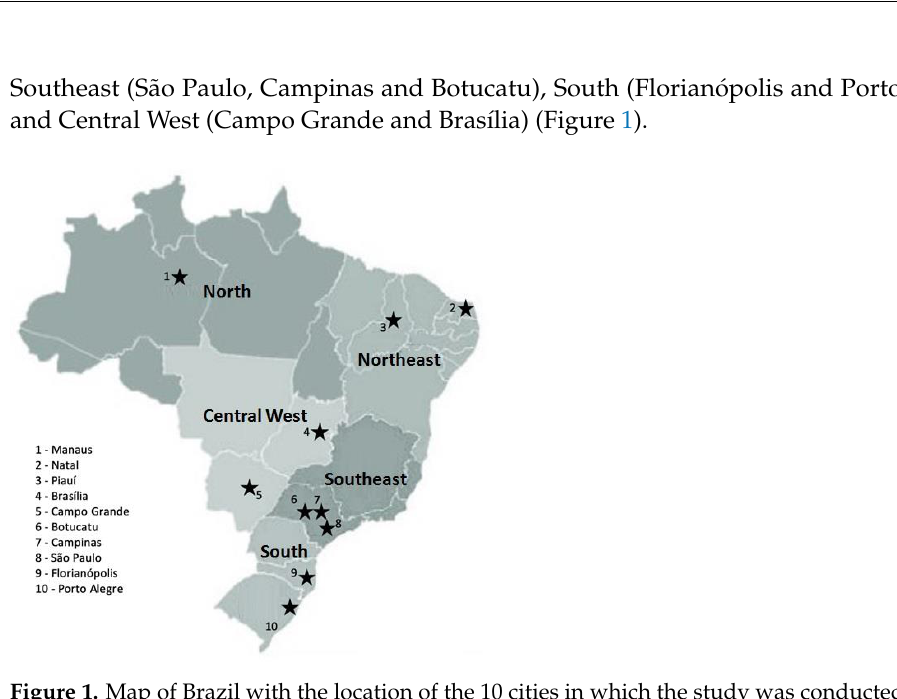
Figure 1. Map of Brazil with the location of the 10 cities in which the study was conducted.